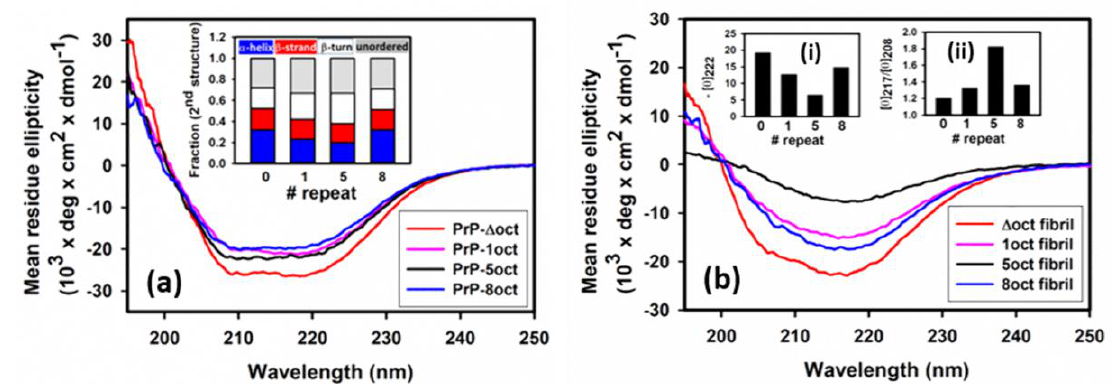
Figure 2. Circular dichroism (CD) analysis of ( a ) PrP variants and ( b ) fibrils converted from four PrP variants.